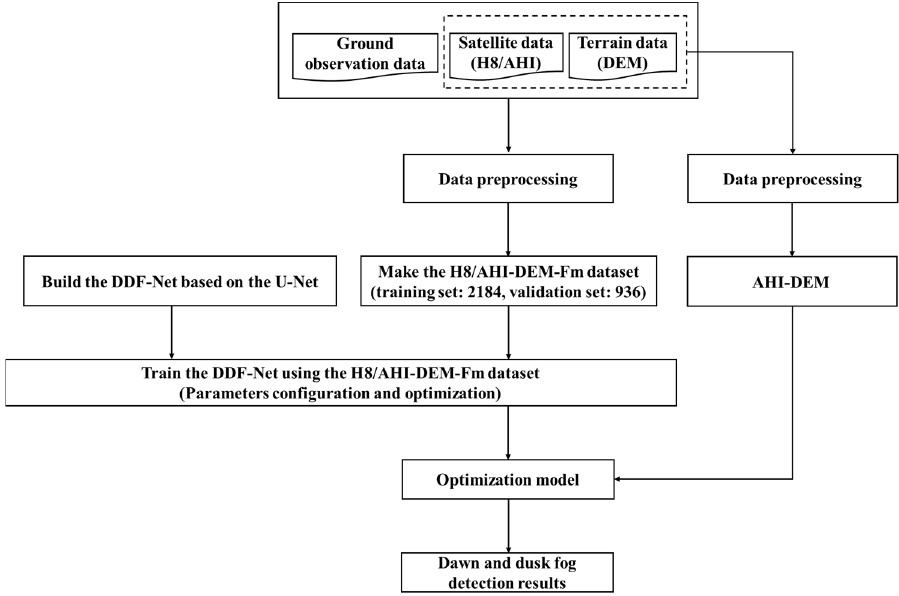
Figure 3. Flow chart of the methodology.